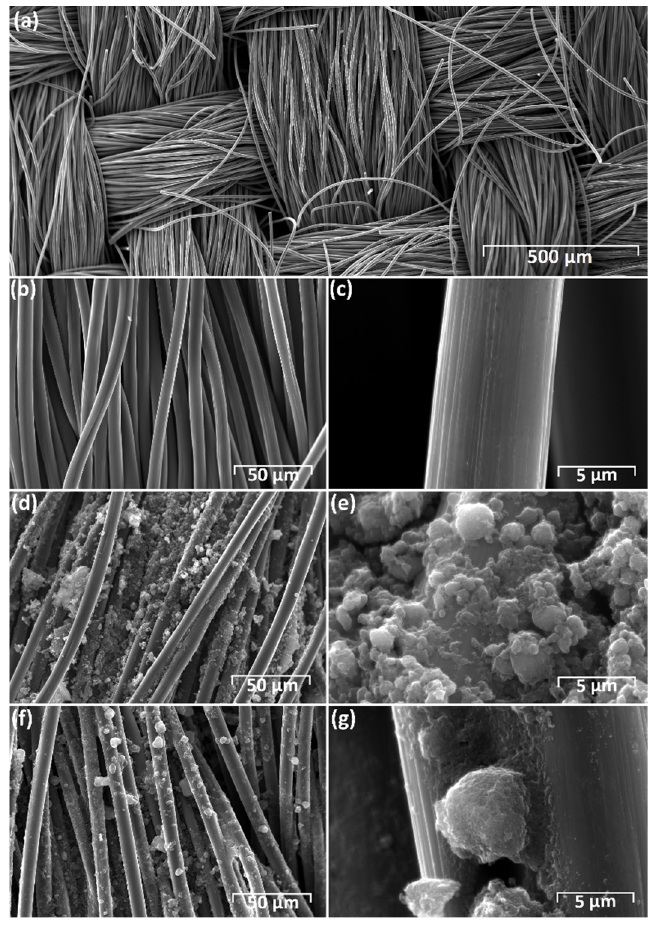
Figure 3. SEM images of HCB1071 carbon cloth: ( a – c ) as received, ( d , e ) CB-modified electrodes, and ( f , g ) GnP-modified electrodes. Accelerating voltage, 20 kV. Spot size, 3.0. Working distance, 10 mm.